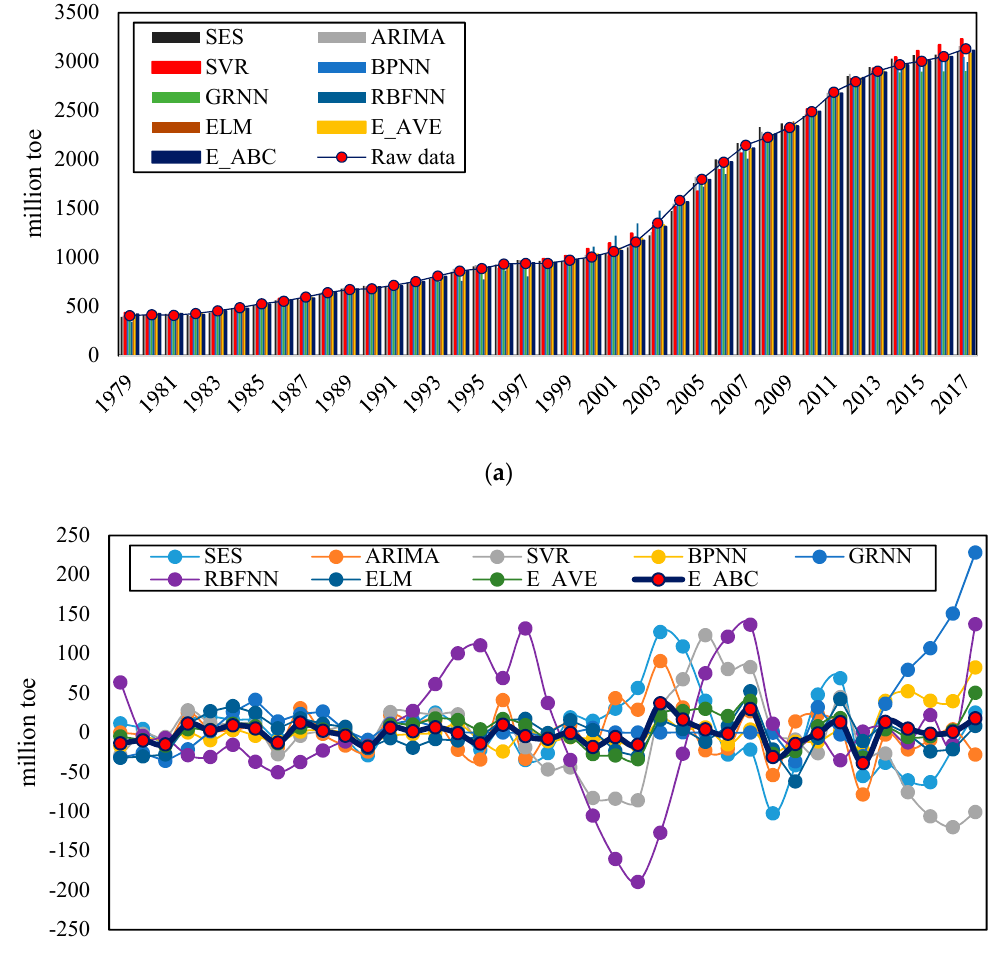
Figure 8. Forecasting results ( a ) and absolute errors ( b ) of each forecasting model.